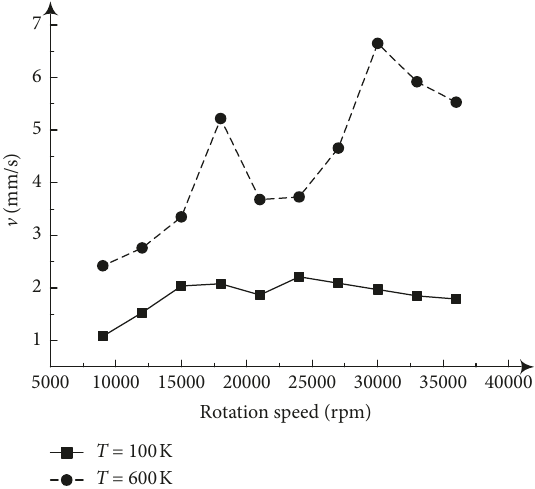
Figure 6: Vibration results at different temperatures.